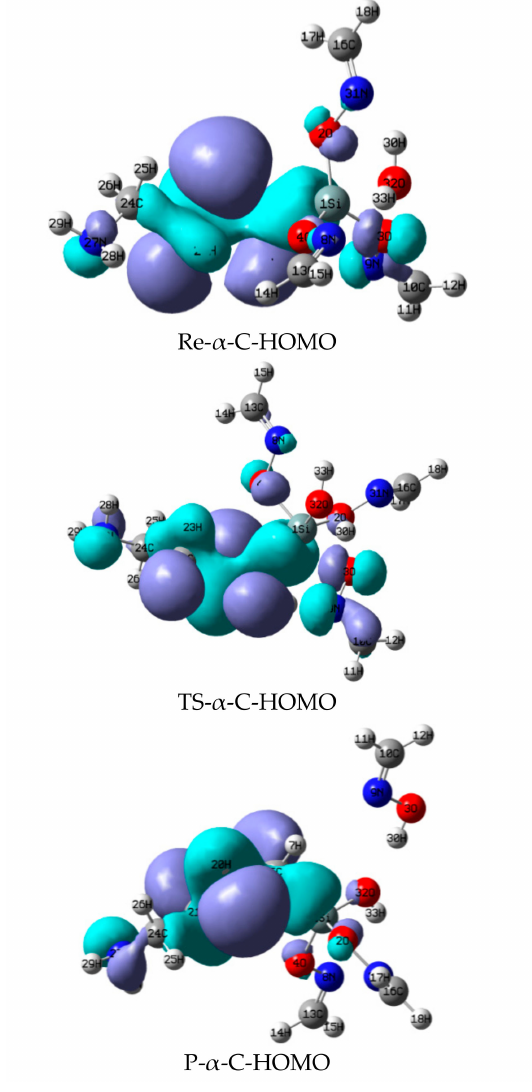
Figure 2. Highest occupied molecular orbital (HOMO) of stationary points of the reaction between α -EAMOS and H 2 O at the B3LYP/6-311G**